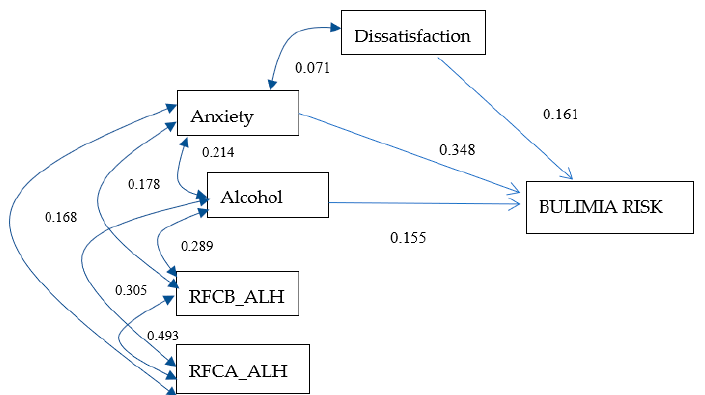
Figure 4. Bulimia risk model for women. The values on one-headed arrows are the standardized regression weights and those on each two-headed arrow are the correlations for the model. The shapes in the diagram are defined as follows: small ovals are measurement or prediction errors; rectangles, measured variables. RFCB_ALH: food restriction before consuming alcohol. RFCA_ALH: food restriction after consuming alcohol. X 2 = 3.358, p = 0.645, CFI = 1.0, PNFI = 0.327, RMSEA = 0.000, and R 2 = 0.202.